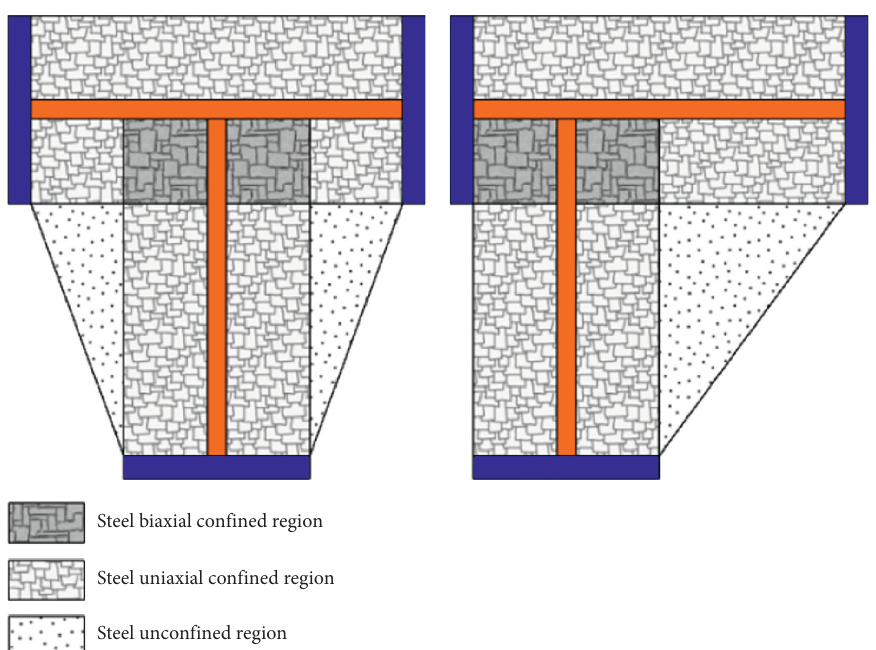
Figure 13: Regional partition of the concrete in SRC-core columns with T-shaped and L-shaped